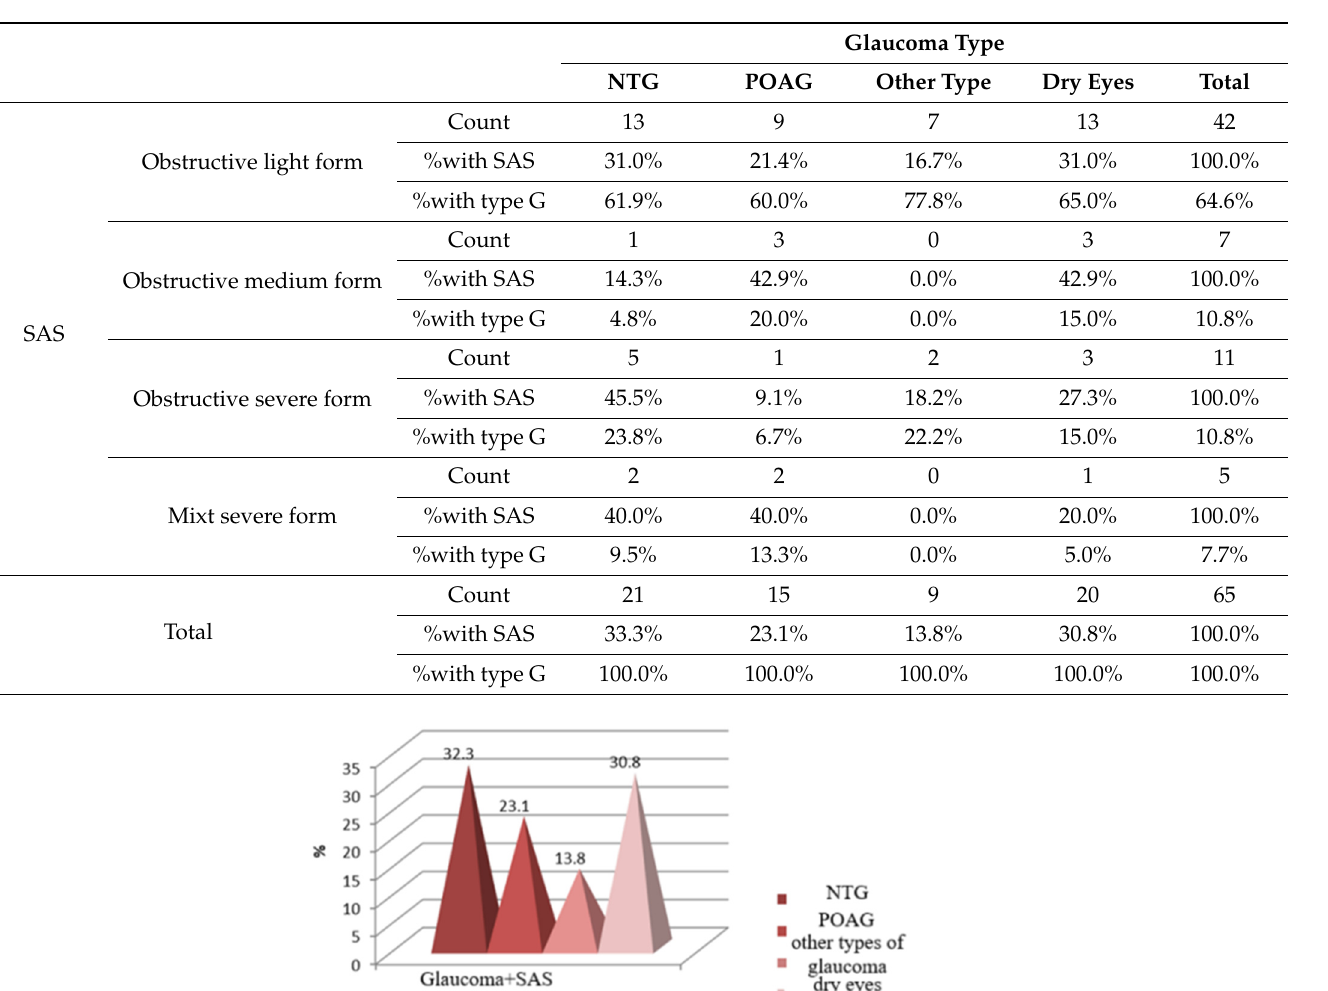
Table 1. Percentage distributions of sleep apnea syndrome by type of glaucoma (NTG, POAG, other types of glaucoma) and dry eye syndrome.